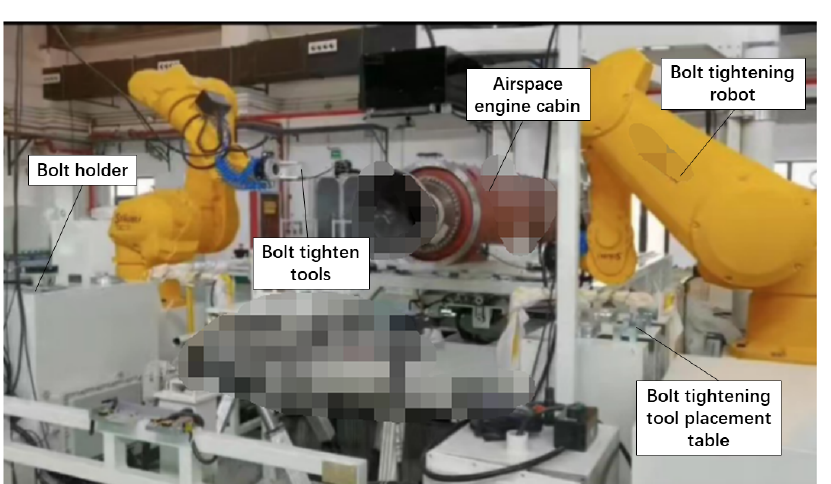
Figure 1. Bolt tightening scheme.